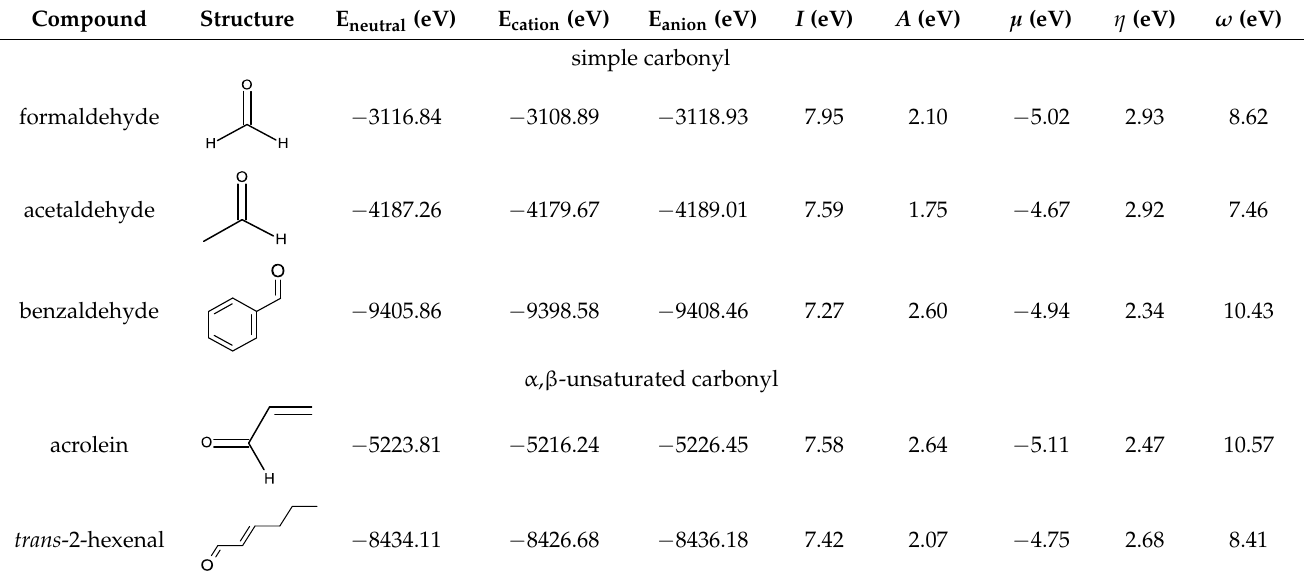
Table 2. Global reactivity descriptors ( I , A , μ , η , and ω ) calculated using density functional theory. Compound